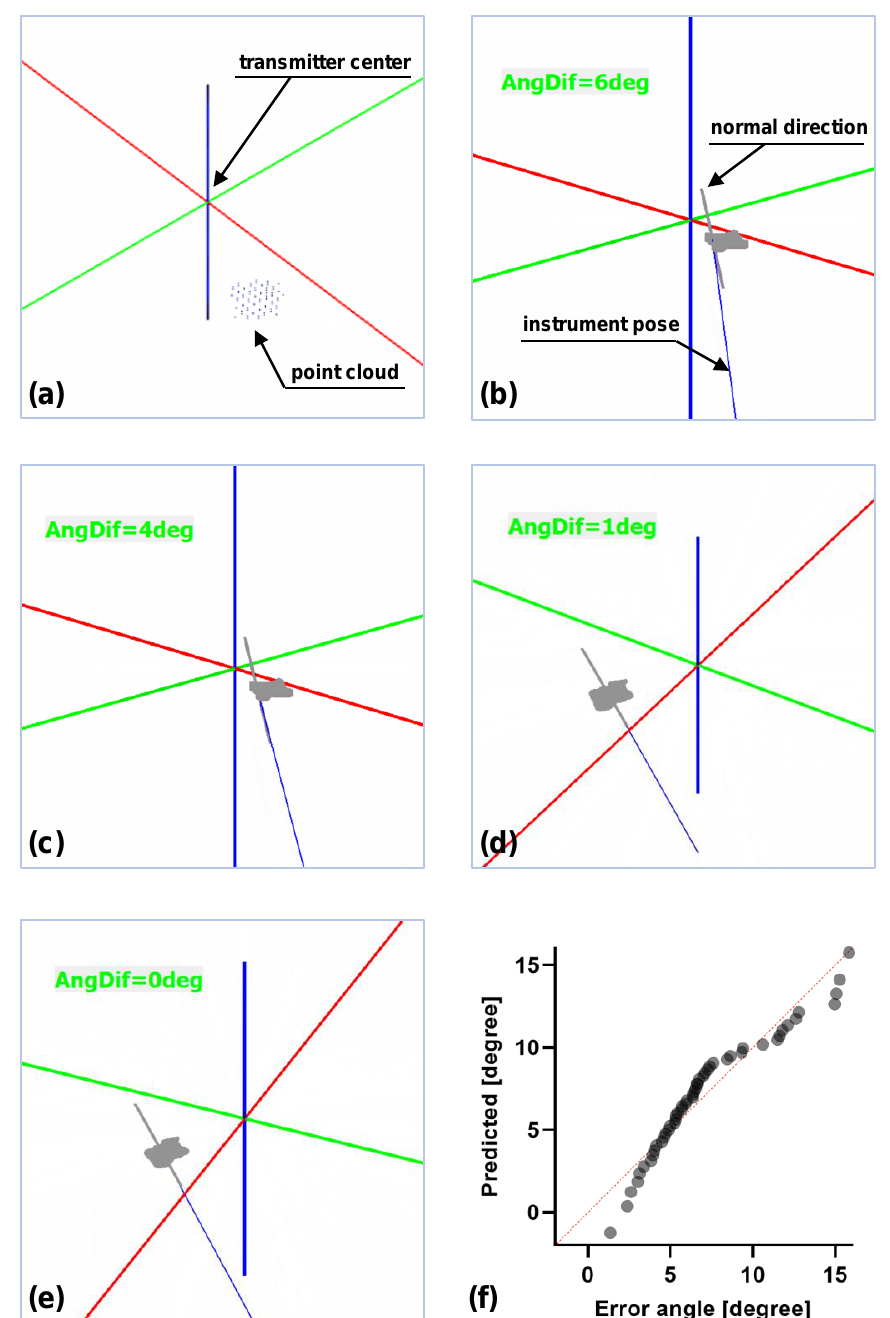
Figure 9. Experimental results on pose evaluation. ( a ) 3D point cloud (blue) of a partial shell. ( b – d ) Visual guidance displayed on a monitor to navigate the best pose. The instrument pose is adjusted. The error angles are 6 deg, 4 deg, and 1 deg. ( e ) The instrument pose (blue line) overlaps with the real normal direction (grey line) on the current position, with an optimal pose of zero error angle. ( f ) Results distribution of the error angle. Fifty positions are collected from the shell